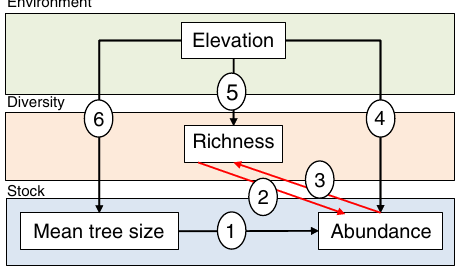
Fig. 2 Causality in the abundance – diversity relationship. Theoretical model arranged as a path diagram in which the arrows indicate the direction of potential causal effects. Path (1) represents Yoda ’ s law in the sense that a negative relationship is expected between the size of trees and abundance per unit area. Paths (4), (5), and (6) represent gradients in abundance, species richness and mean tree size (i.e. mean diameter at breast height) along the elevation gradients. Paths (2) and (3) are non- recursive paths indicative of more species and more individuals hypotheses, respectively. Comparison of models including one or the other path gives support to one or the other hypotheses,